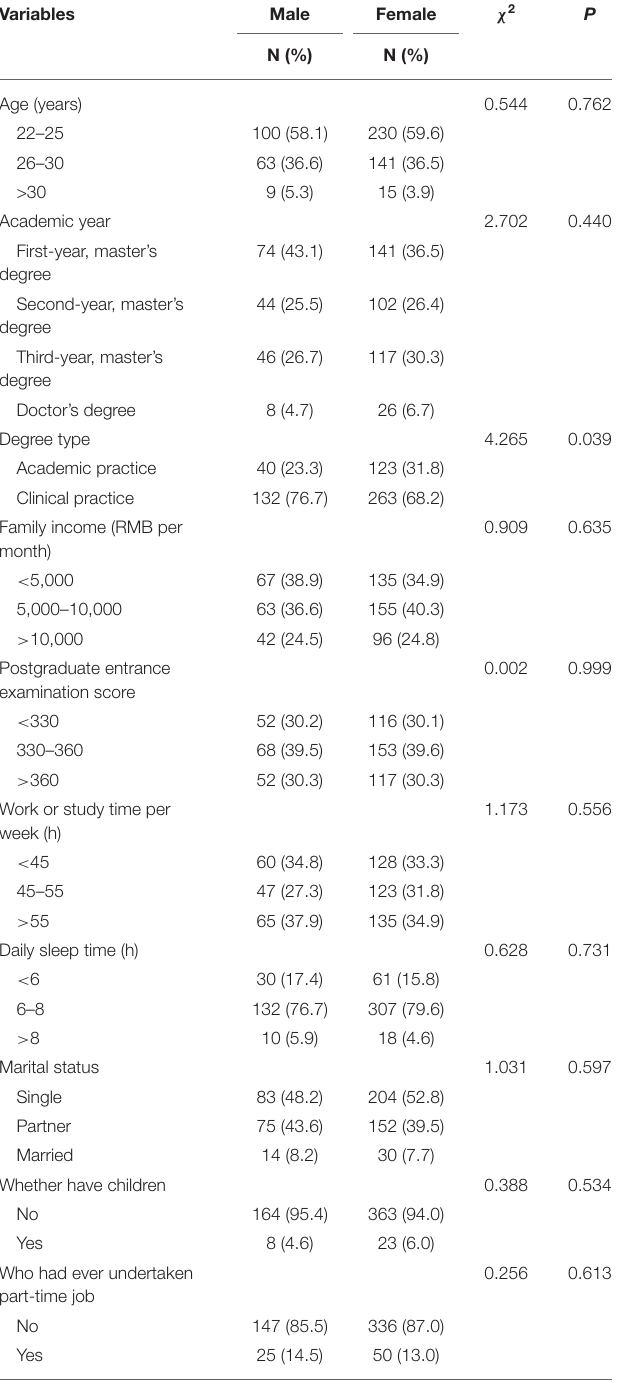
the common risk factors for males and females in job burnout and career choice regret. Table 4 shows that job burnout and career choice regret were the common risk factors for depressive symptoms in males and females ( P < 0.05). Multicollinearity analysis results indicated no severe collinearity between variables in job burnout, career choice regret, and depressive